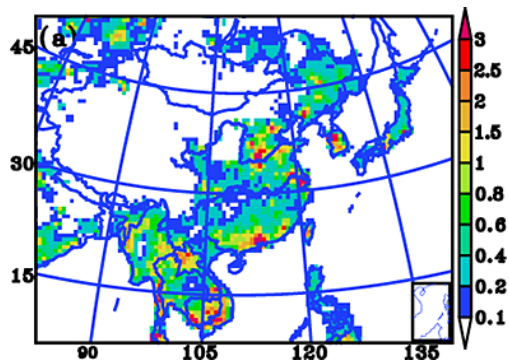
Figure 8. Monthly mean RMSEs of F a t in February 2010 (units: µmolem − 2 s − 1 )